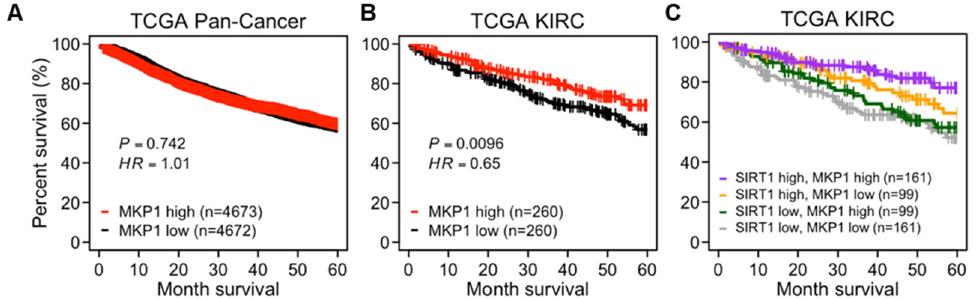
Figure 6. Prognostic significance of MKP1 with SIRT1 expression. ( A – C ) The Kaplan–Meier plots showing the OS of cancer patients in TCGA data. The OS stratified by MKP1 -high and -low patient groups in a pan-cancer cohort ( A ); the OS stratified by MKP1 -high and -low groups in patients of kidney renal clear cell carcinoma (TCGA KIRC) ( B ); the OS stratified by the combination of SIRT1 -high / -low and MKP1 -high / -low groups in patients of TCGA KIRC ( C ). HR and p-values derived from comparisons among individual groups are placed in Figure S6.